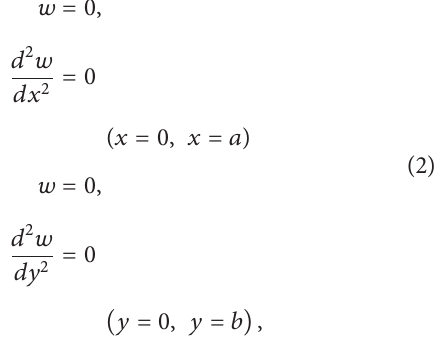
Figure 1: Load bearing structure containing floor slab with internal support.